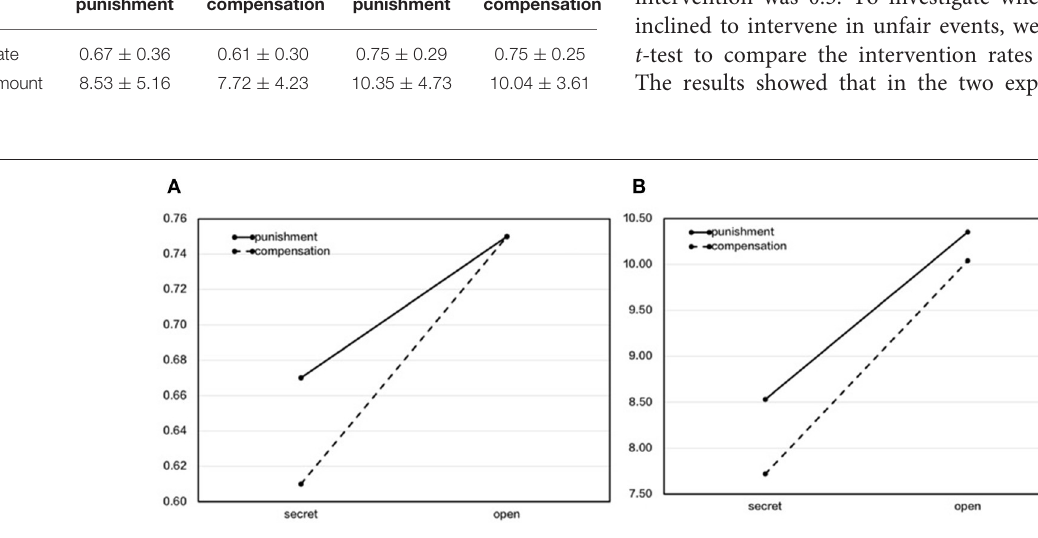
Frontiers in Psychology |